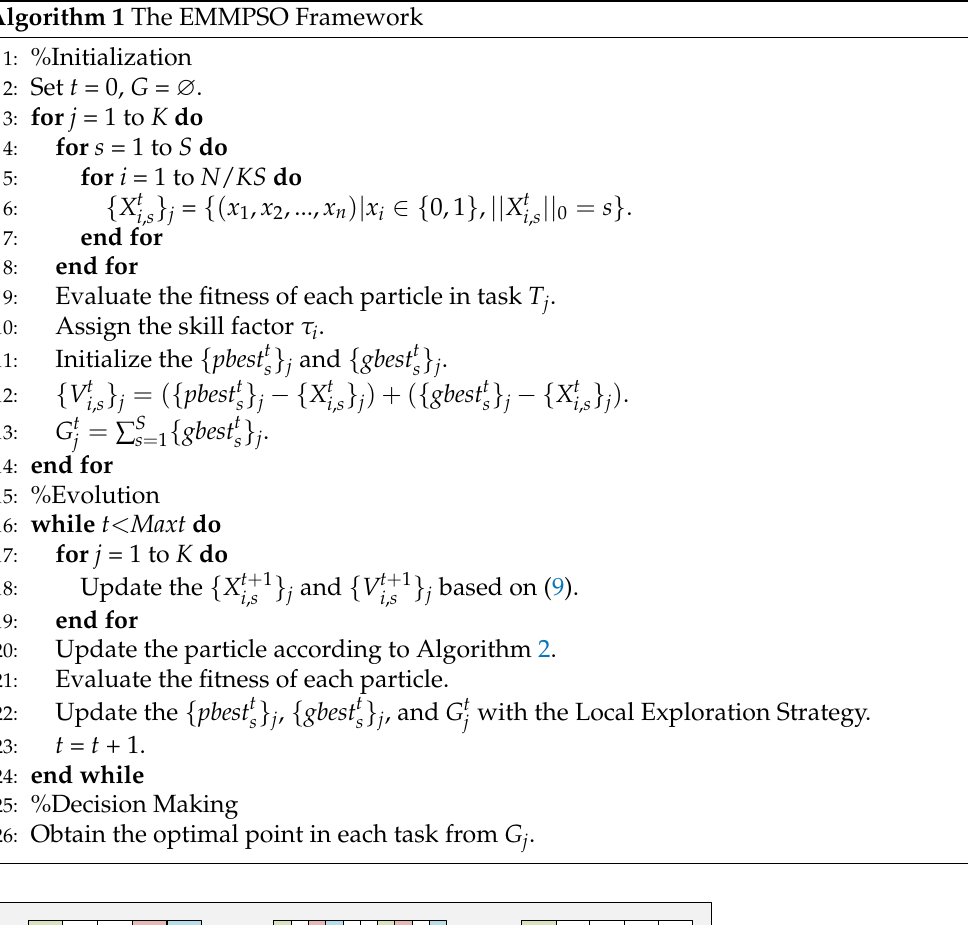
Algorithm 1 The EMMPSO Framework